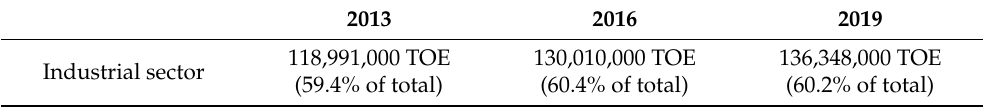
Table 1. Energy consumption of the industrial sector (percent of the total energy consumed) in